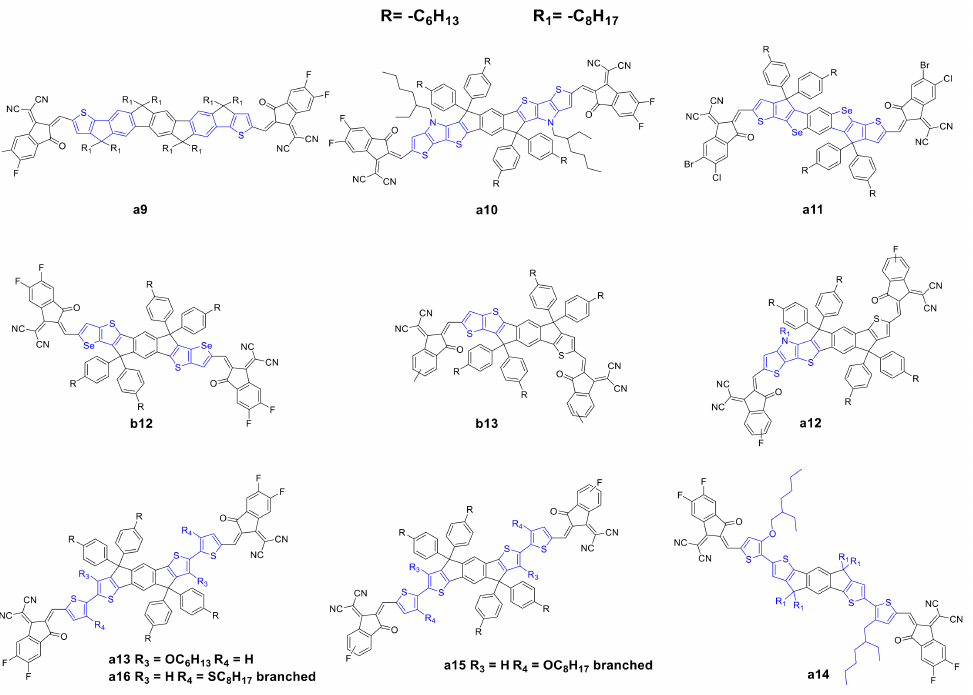
Figure 4. Structure of the of acceptors of the IDIC / ITIC families, where the flanking units of a0 or b0 have been